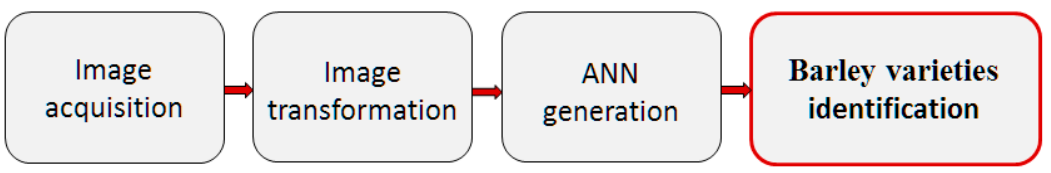
Figure 5. The creational pattern of a neural classifier.